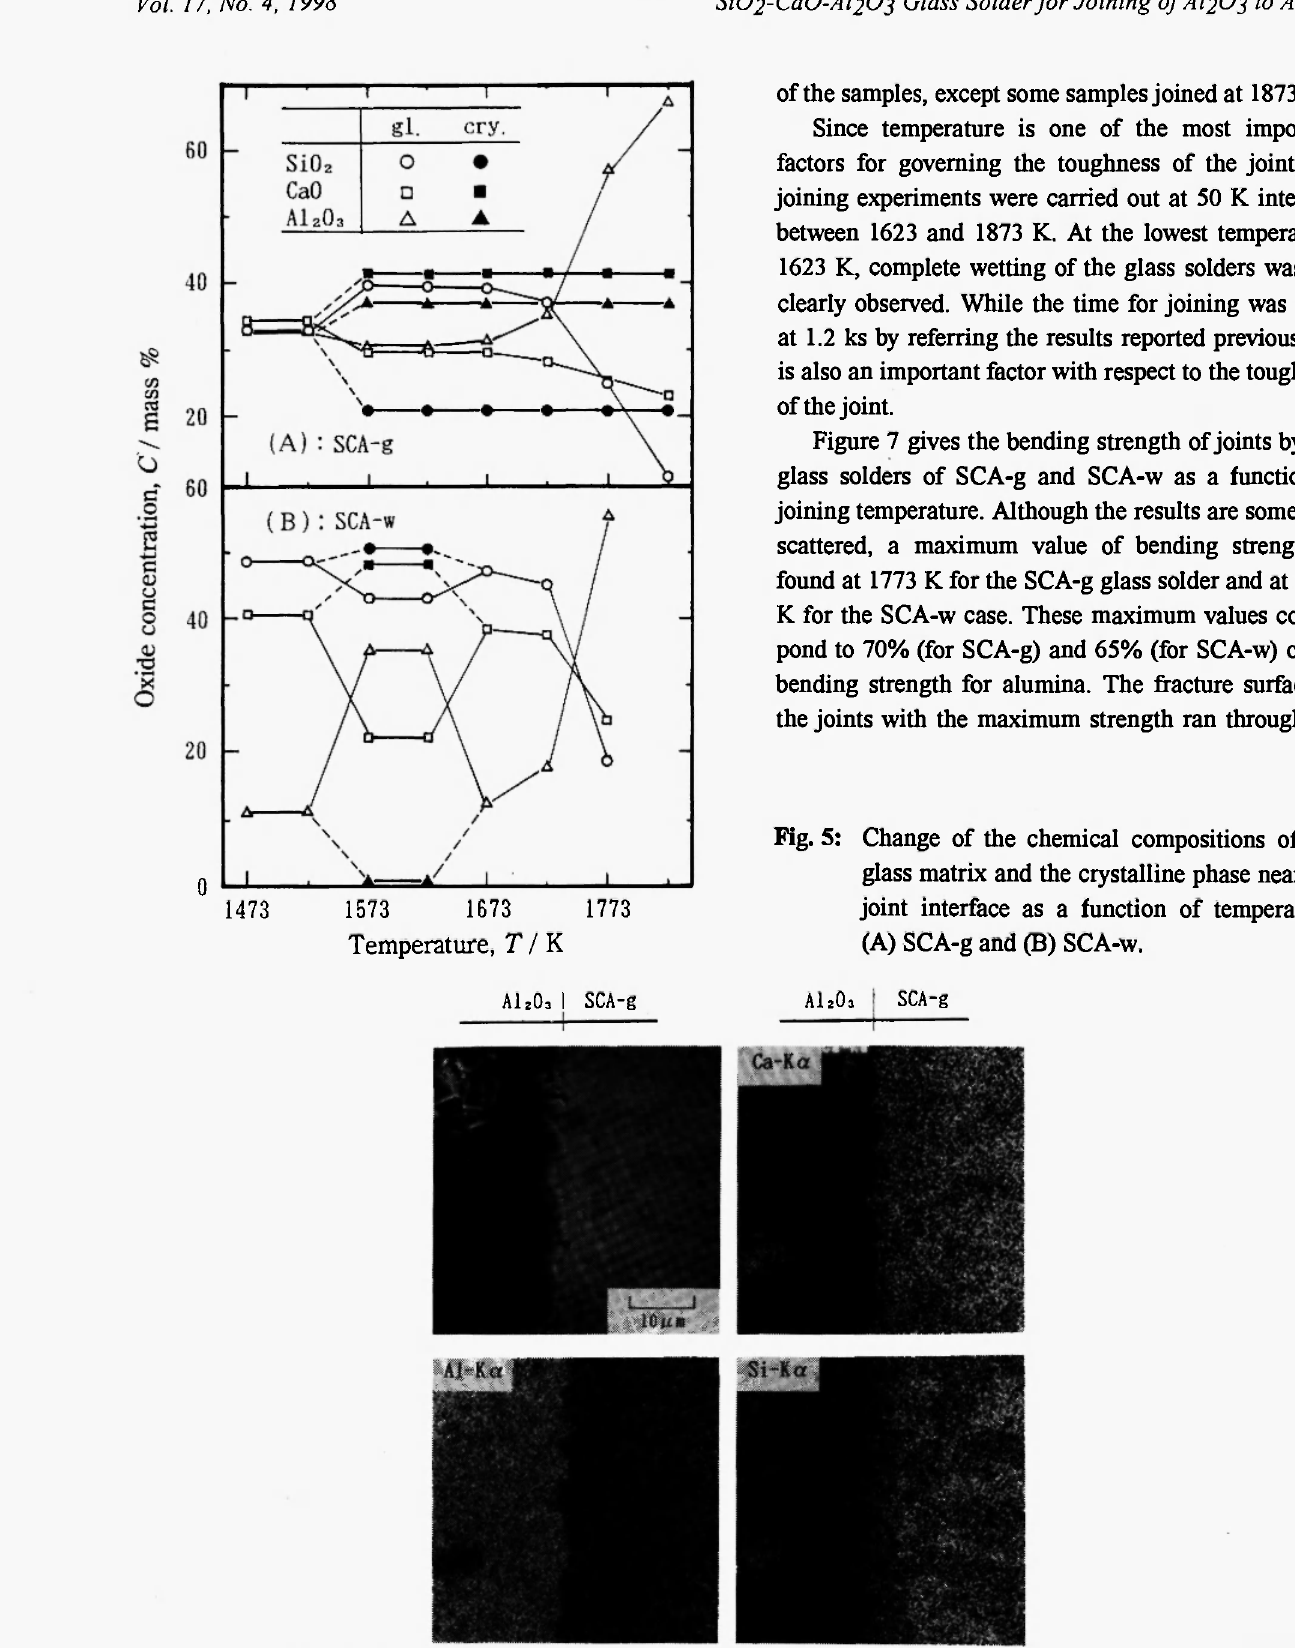
Fig. 5: Change of the chemical compositions of the glass matrix and the crystalline phase near the joint interface as a function of temperature. (A) SCA-g and (B) SCA-w.